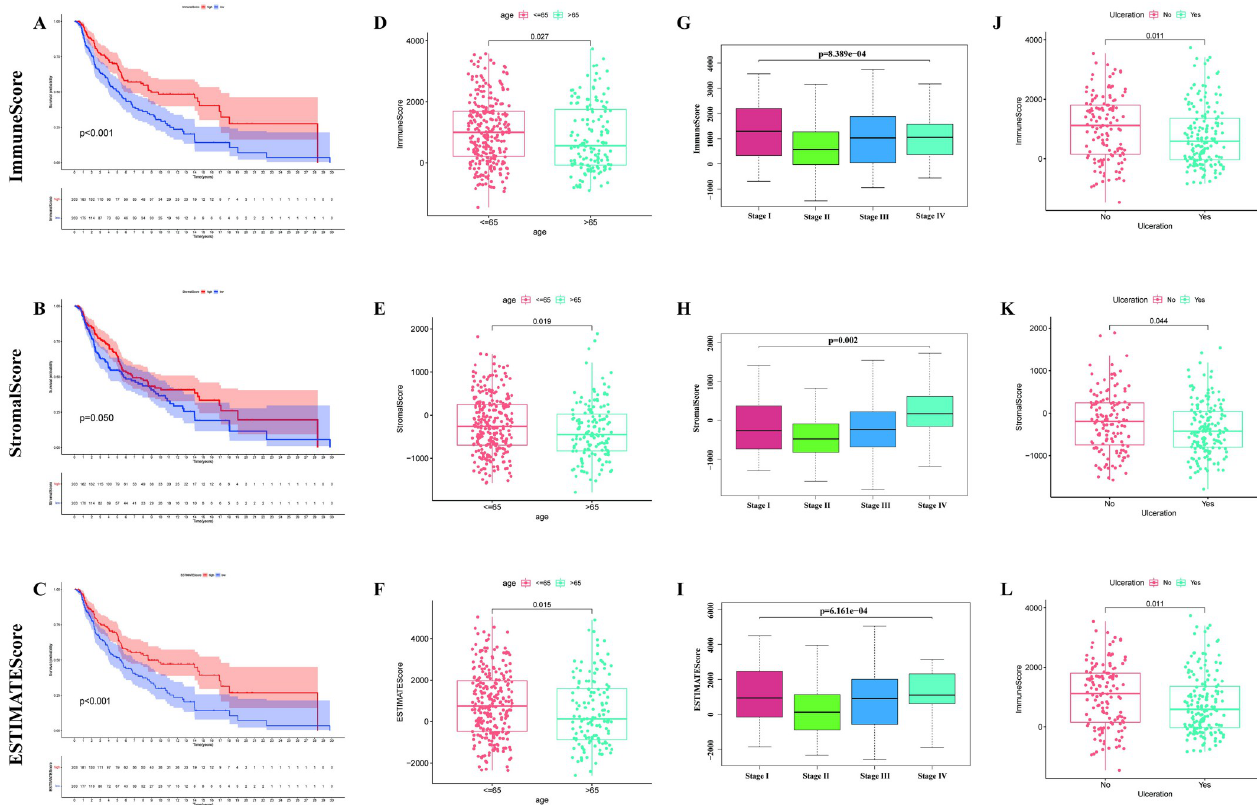
Fig 2. Survival curve and correlation analysis between TME and clinical features. (A) Kaplan-Meier survival analysis of ImmuneScore. (B) Survival analysis result of StromalScore. (C) Survival analysis of ESTIMATEScore. (D-L) Correlation analyses among ImmuneScore, StromalScore, and ESTIMATEScore and age, Stage, and